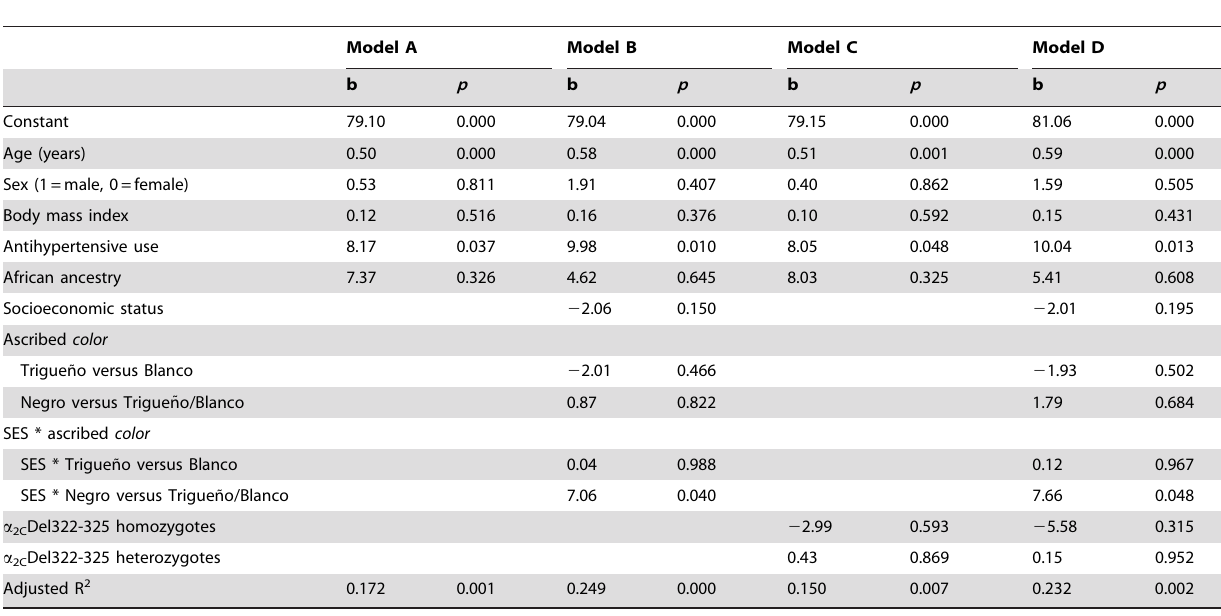
Table 3. Multiple linear regression coefficients (B) for diastolic blood pressure (DBP) on genetic ancestry, ascribed color , socioeconomic status, a 2C adrenergic receptor genotype, and standard